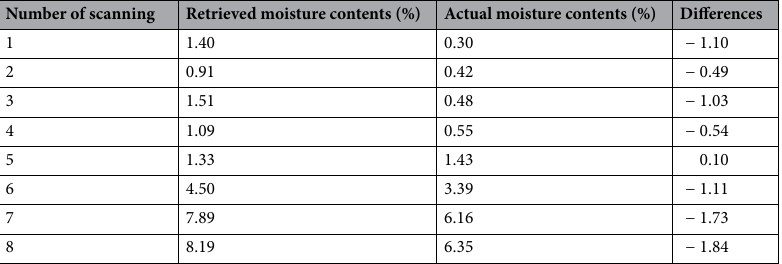
Table 6. The differences between the retrieved moisture content and the actual moisture content of the specimen.